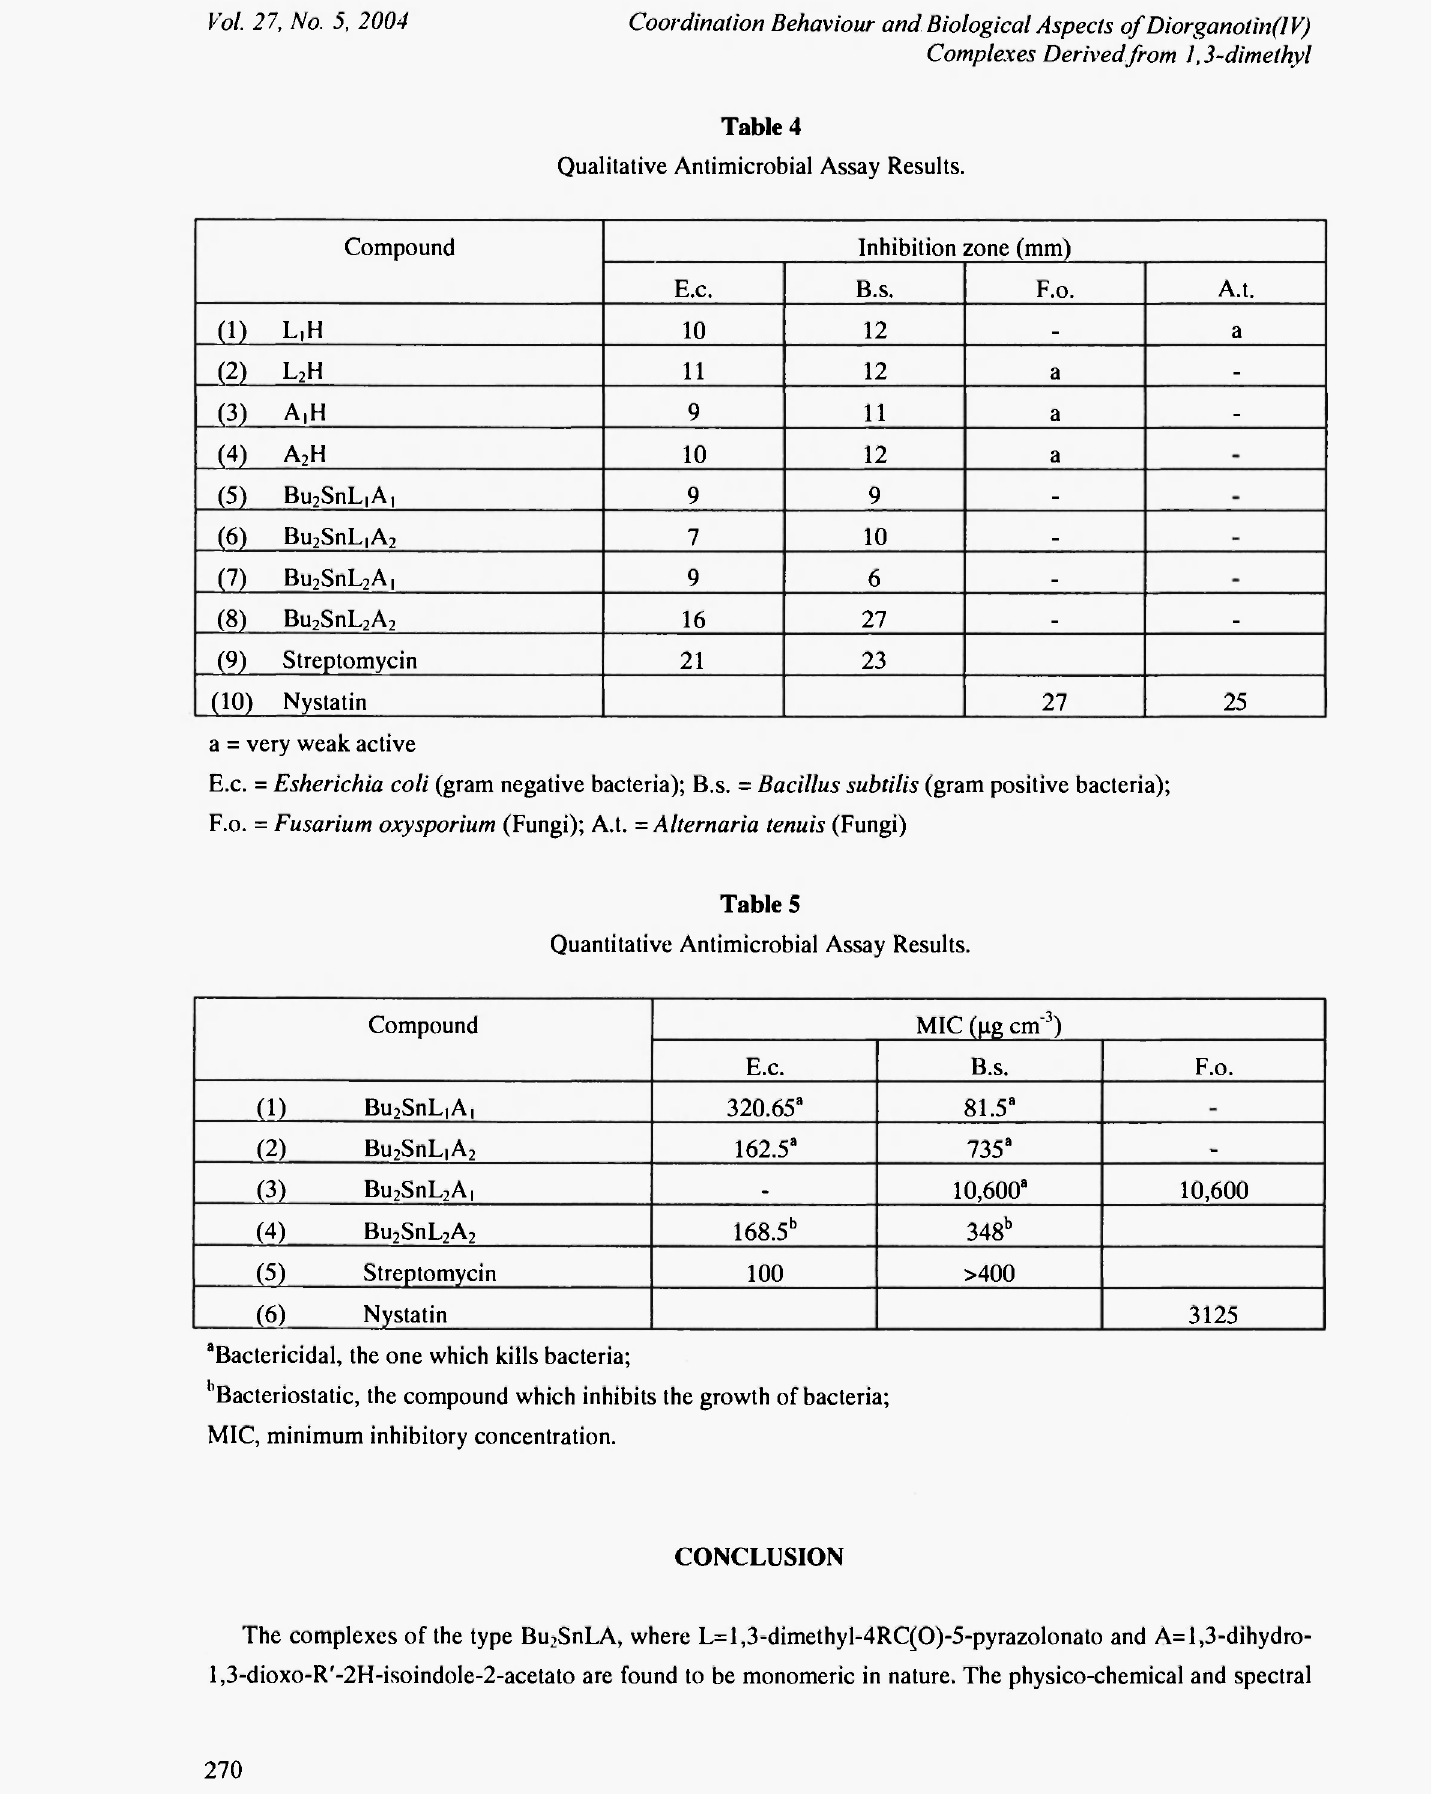
Qualitative Antimicrobial Assay Results.